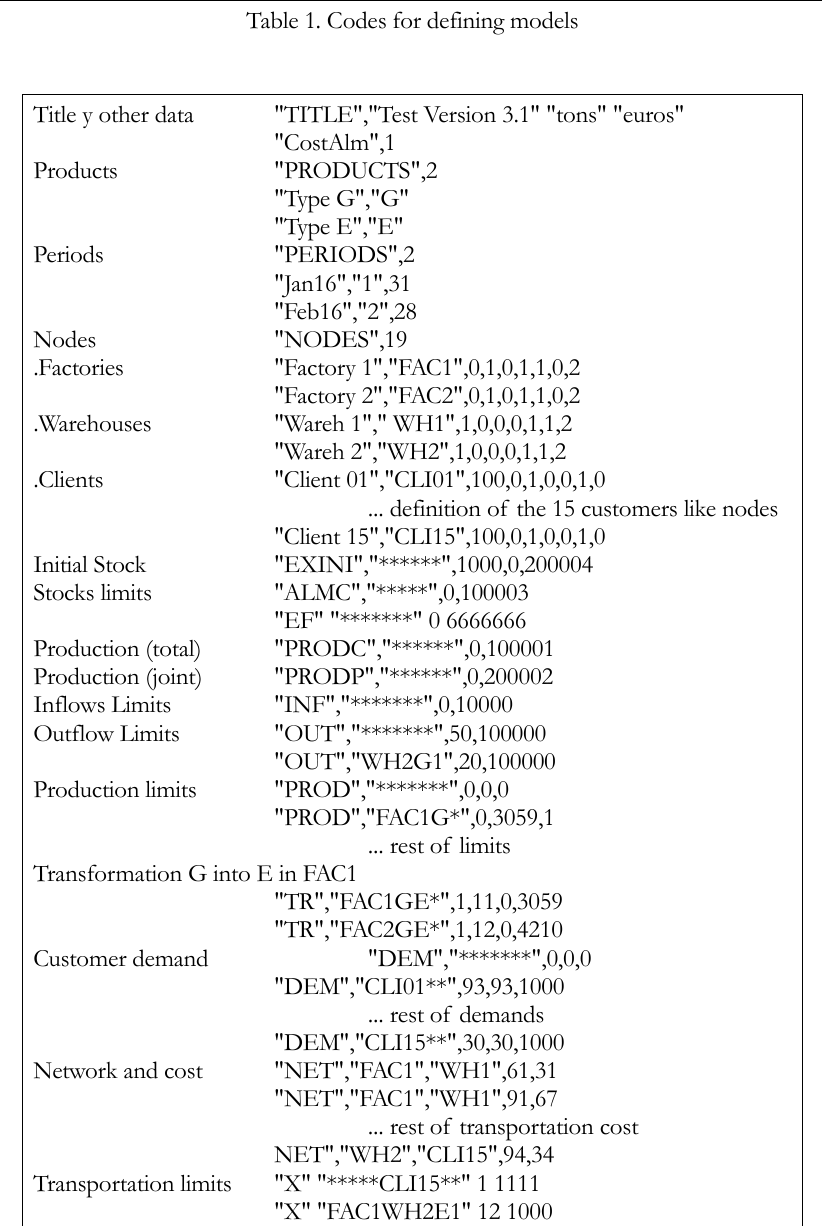
Table 2. A simple model